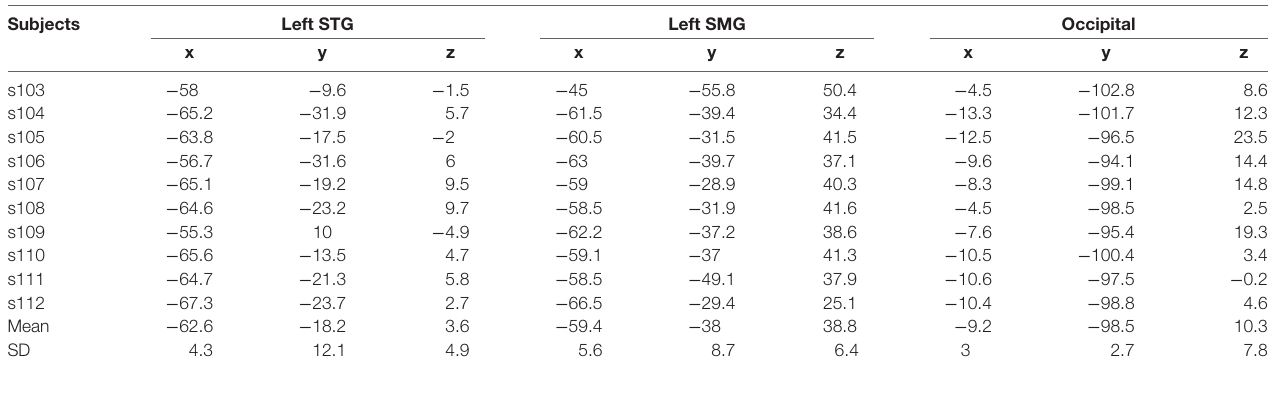
TABLE 1 | Talairach coordinates of the target regions in the TMS experiment.